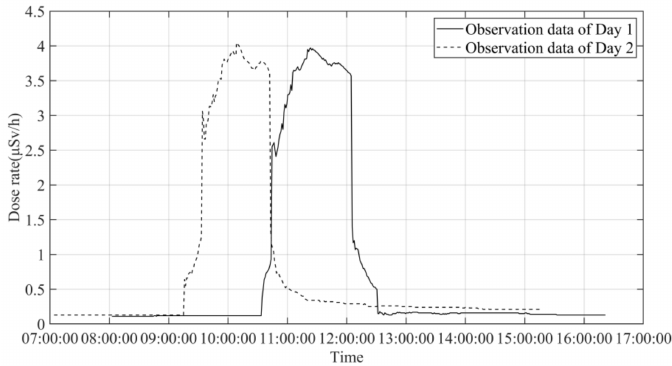
Figure 7. Time series of the radiation dose rate detected on Day 1 (solid line) and Day 2 (dash line),